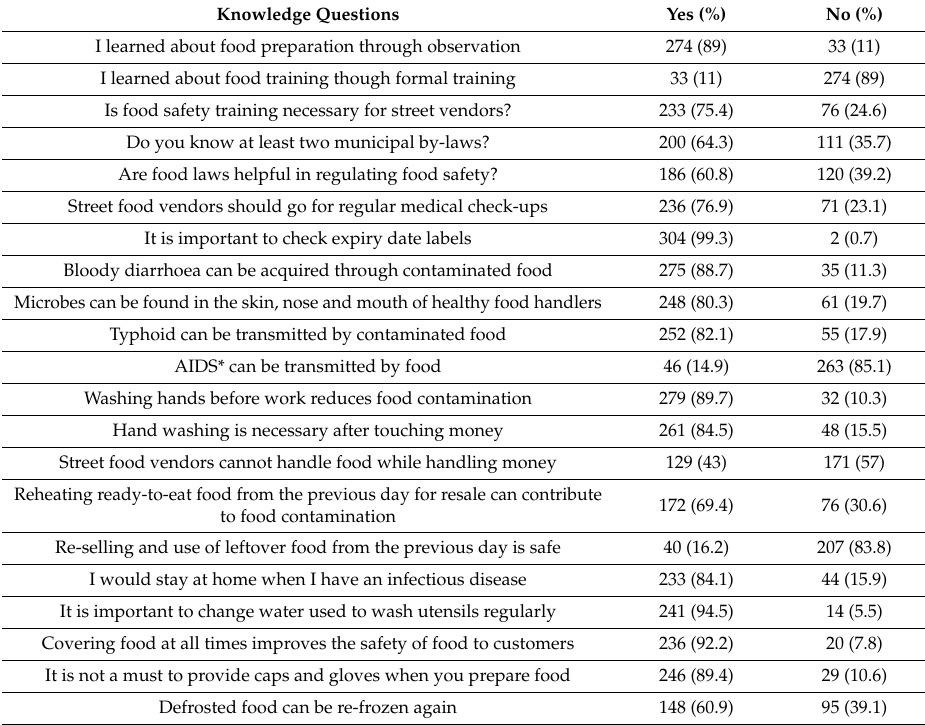
Table 2. Street food vendors’ knowledge of food safety.